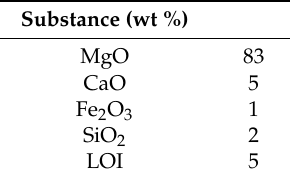
Table 1. Chemical composition of used MgO powder.